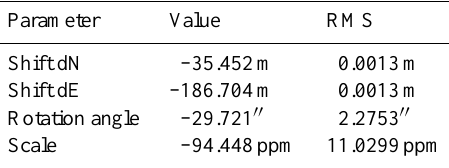
Table 6. Transformation parameters from Bolu to D¨uzce, piers 57 to 49.